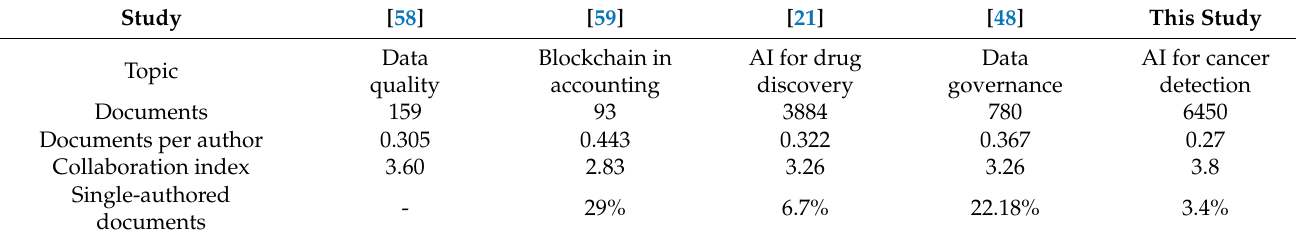
Table 2. Comparison of different bibliometric